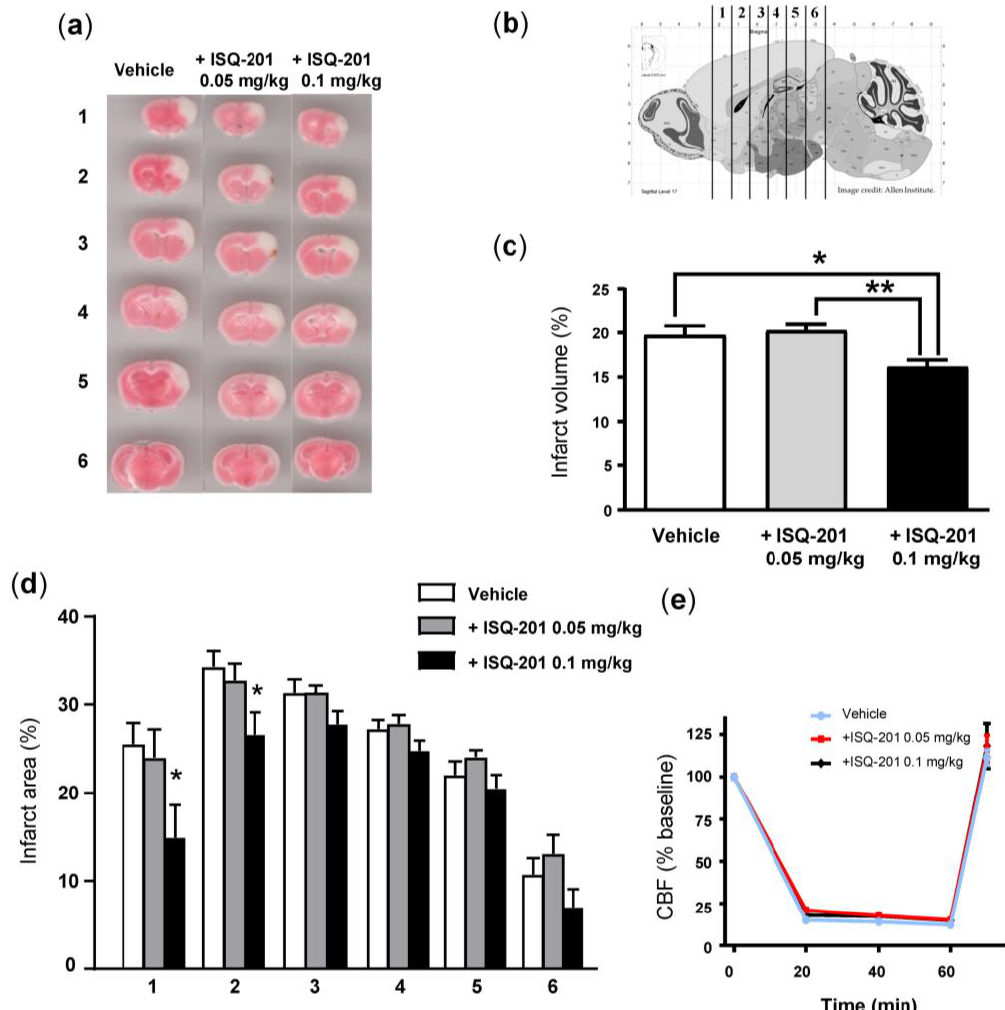
Figure 8. Neuroprotective effect of ISQ-201 in transient focal cerebral ischemia. ISQ-201 treatment reduces infarct size after transient middle cerebral artery occlusion (tMCAO). Vehicle or ISQ-201 (0.05 and 0.1 mg/kg) was administered at the onset of the reperfusion after tMCAO, and infarct size was quantified at 48 h of reperfusion. Brain sections from ischemic animals were stained with 2,3,5-triphenyltetrazolium chloride (TTC) to determine the infarct size. ( a ) Representative images of TTC-stained brain sections of ischemic mice. Six coronal sections (1 mm) of the rostrocaudal axis are shown. ( b ) The schematic figure shows the sections of the coronal slices in the whole brain (illustration from Franklin, K.; Paxinos, G. The Mouse Brain in Stereotaxic Coordinates, 3rd ed.; Academic Press: San Diego, CA, USA, 2007. Image credit: Allen Institute). The bar graphs in ( c ) and ( d ) showed the quantification of the infarct volume and infarct area, respectively, in ISQ-201-treated animals, compared to the vehicle. Values represent the mean of 9 independent animals, and SE is indicated by the error bars, * p < 0.05, compared to the vehicle, and ** p < 0.01 through Bonferroni’s post-test after ANOVA. ( e ) The cerebral blood flow (CBF) of all studied animals is represented to show that the surgical procedure of tMCAO was properly performed in the three groups. Data are represented as mean ±